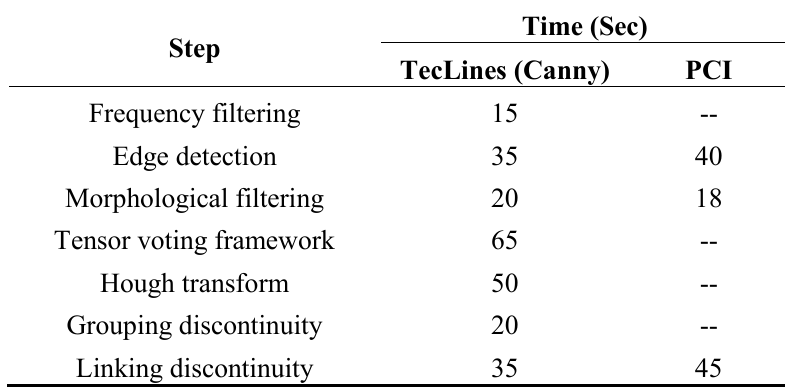
Table 4. Computational time for image discontinuities extraction using TecLines toolbox, and LINE module of the PCI Geomatica